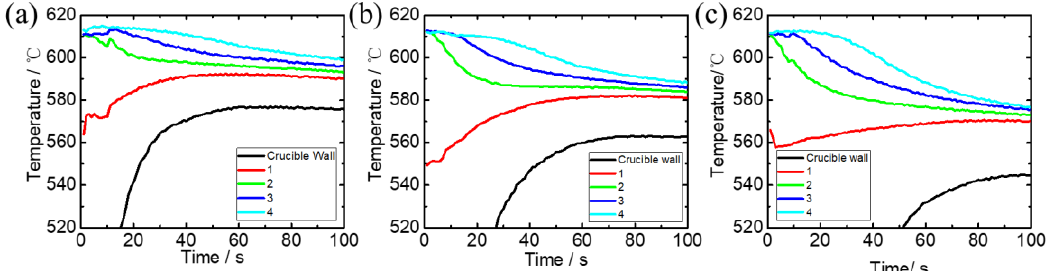
Figure 6. Temperature measuring results for the three slurries in crucibles with different wall thickness, ( a ) 2.8 mm, ( b ) 4.2 mm, ( c ) 5.6 mm.